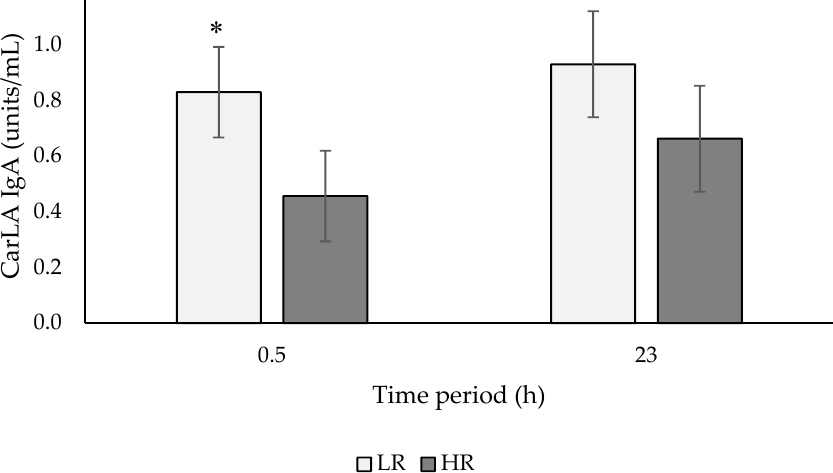
Figure 3. CarLA concentrations (units/mL; means ± SED) of low (LR) and high (HR) ewes after a 0.5 h and a 23 h test period. * For a time period, least square means differ at p < 0.05 (back-transformed means).